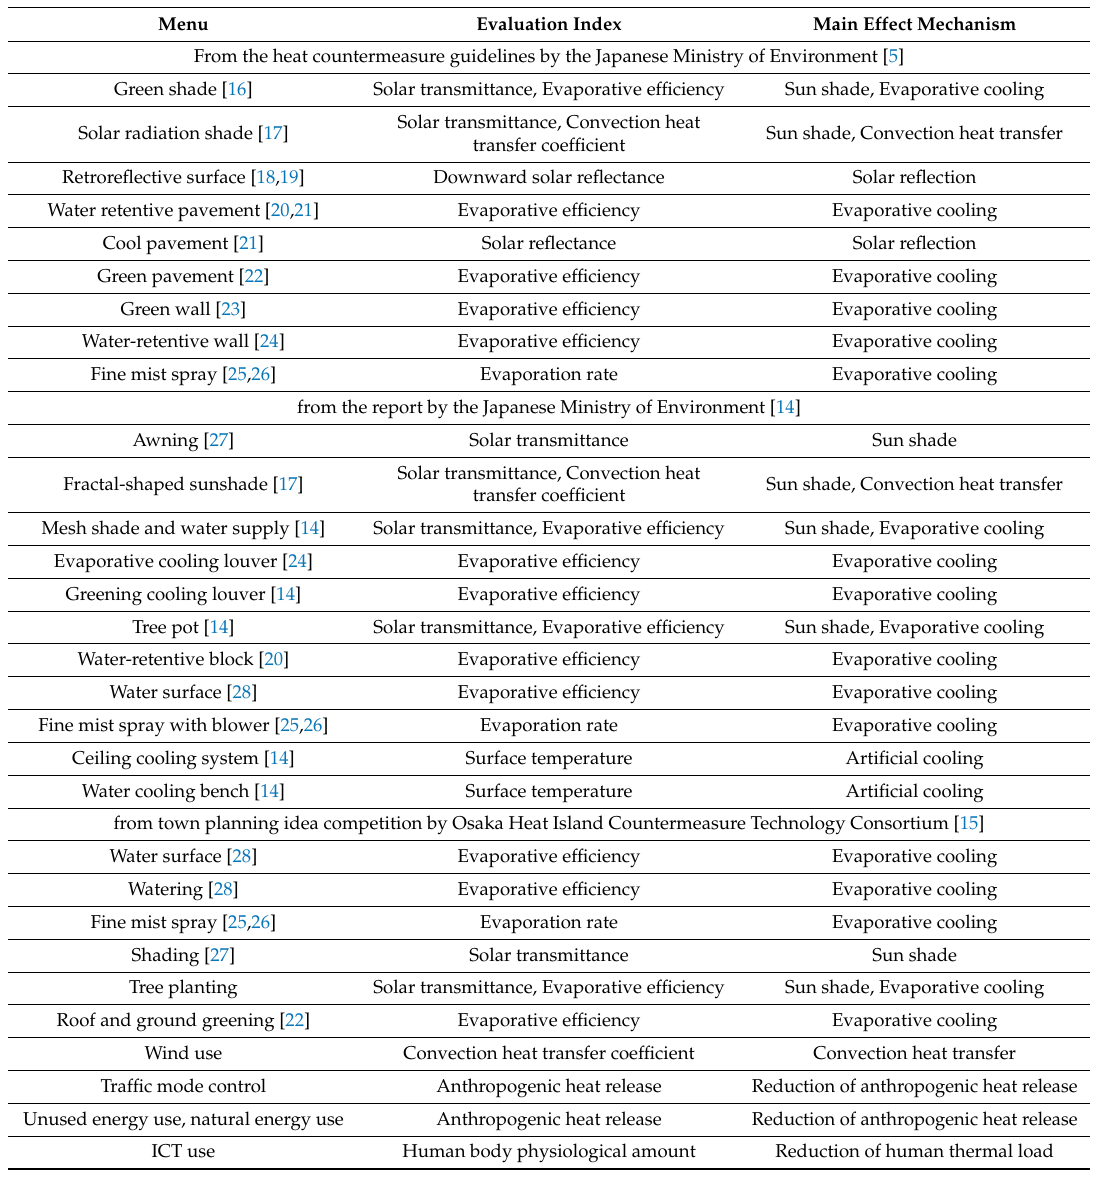
Table 1. Adaptation measures for urban heat islands and their effects and associated evaluation indices.